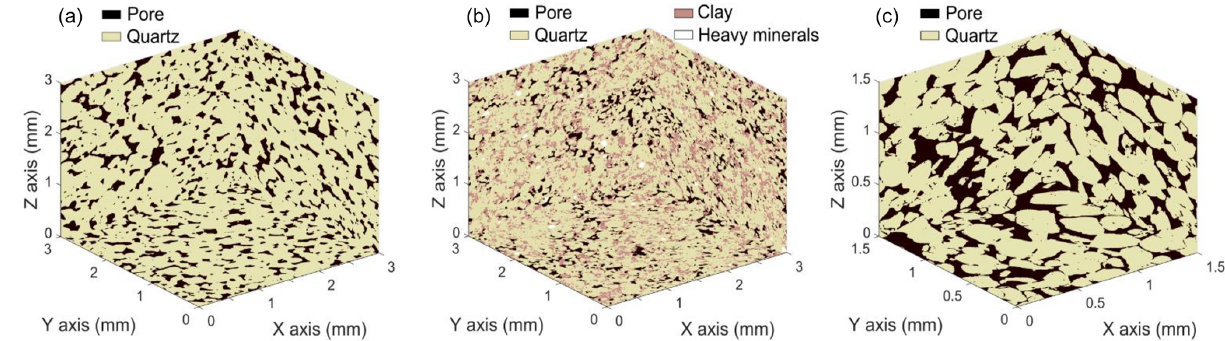
Figure 9. Visualized subvolumes of segmented CT samples of (a) S1, (b) S2 and (c) S3. S1 and S2 in this visualization have volumes of